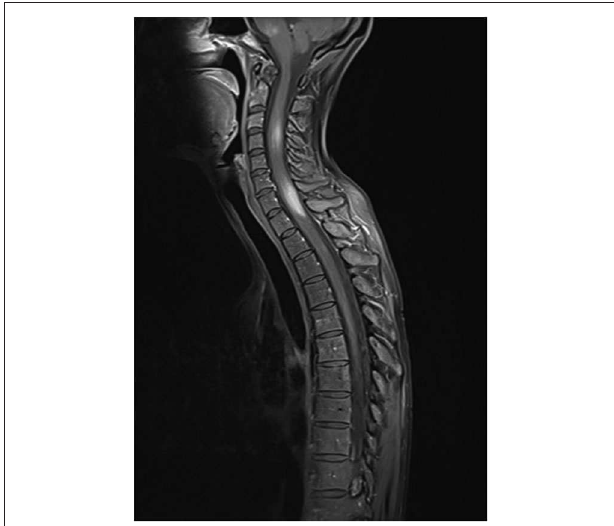
FIGURE 2 | Hyperintense lesions in medulla oblongata and in cervical and upper thoracic spinal cord in contrast enhanced, fat suppressed T1 MRI